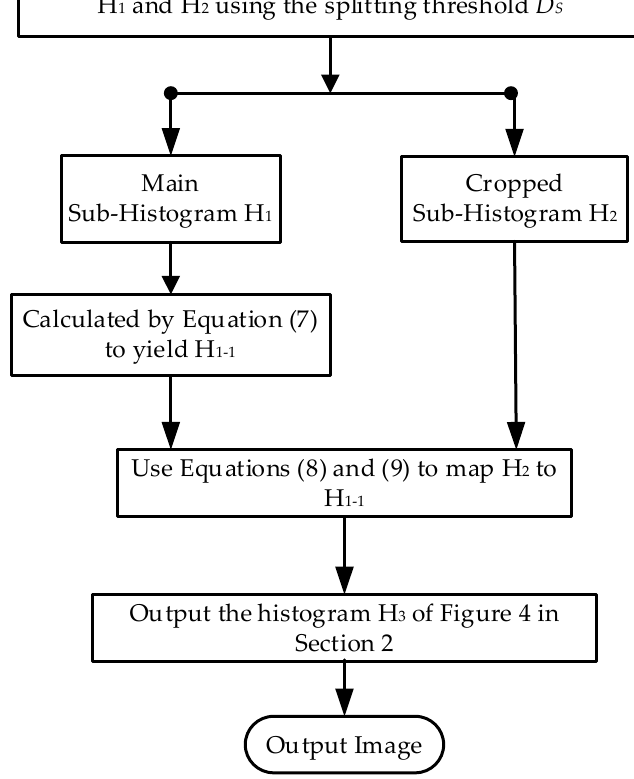
Figure 1. Processing flowchart for a grey-scale image.